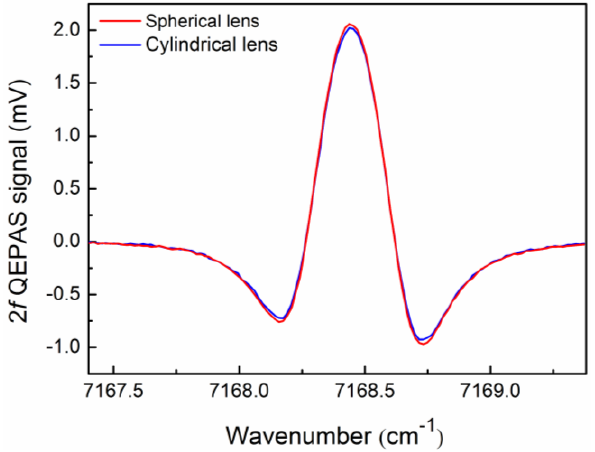
Figure 6. Measured 2 f QEPAS signal at Z of 0.8 mm and a modulation depth of 0.59 cm −1 for cylindrical lens– and spherical lens-based QEPAS sensors, respectively.